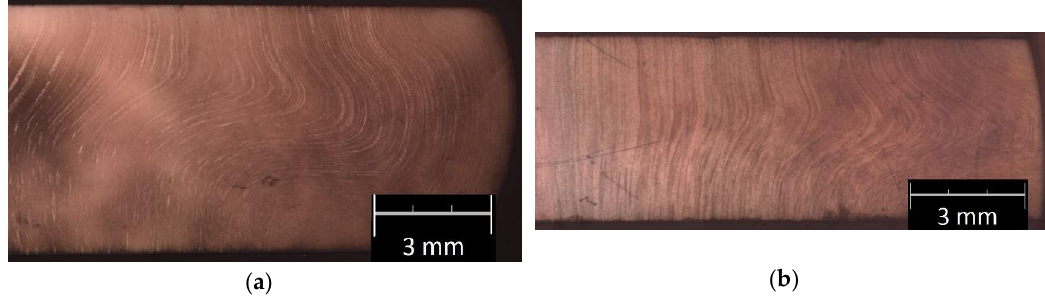
( b ) Figure 4. Microstructure of 42CrMo4 steel annealed according to scheme no. 4 ( a ), ( b ) molybdenum and chromium content in the line-scanned area from ( a ), scanning electron microscopy-energy dispersive spectrometer (SEM-EDS). 3.1.2. Effects of Annealing Schemes on the Macro- and Microstructure of Upset Samples The employed annealing scheme affects the deformability of 42CrMo4 steel. Therefore, peripheral cracking occurs around the barrelled side surface of the upset (compressed) cylinders of the untreated sample, but no cracking occurs during compression of the annealed samples. Figure 5 shows the examples of the transverse macrostructure obtained by upsetting of the as-received sample (0) and the sample annealed according to scheme no. 6. The as-received sample exhibits a much wavier macroscale grain flow than the annealed cross section; see Figure 5. Therefore, the complex flow line arrangement confirms that the as-received steel has lower deformability than the annealed steel sample presented in Figure 5b. It is clear that annealing makes upsetting easier. Figure 6 compares the microstructural development owing to upsetting of the as-received and heat-treated steel. The annealed samples have less lamellar morphology of the cementite and the coarsening of granular tough-carbide phases and ferrite grains. Moreover, in relation to the as-received sample no.